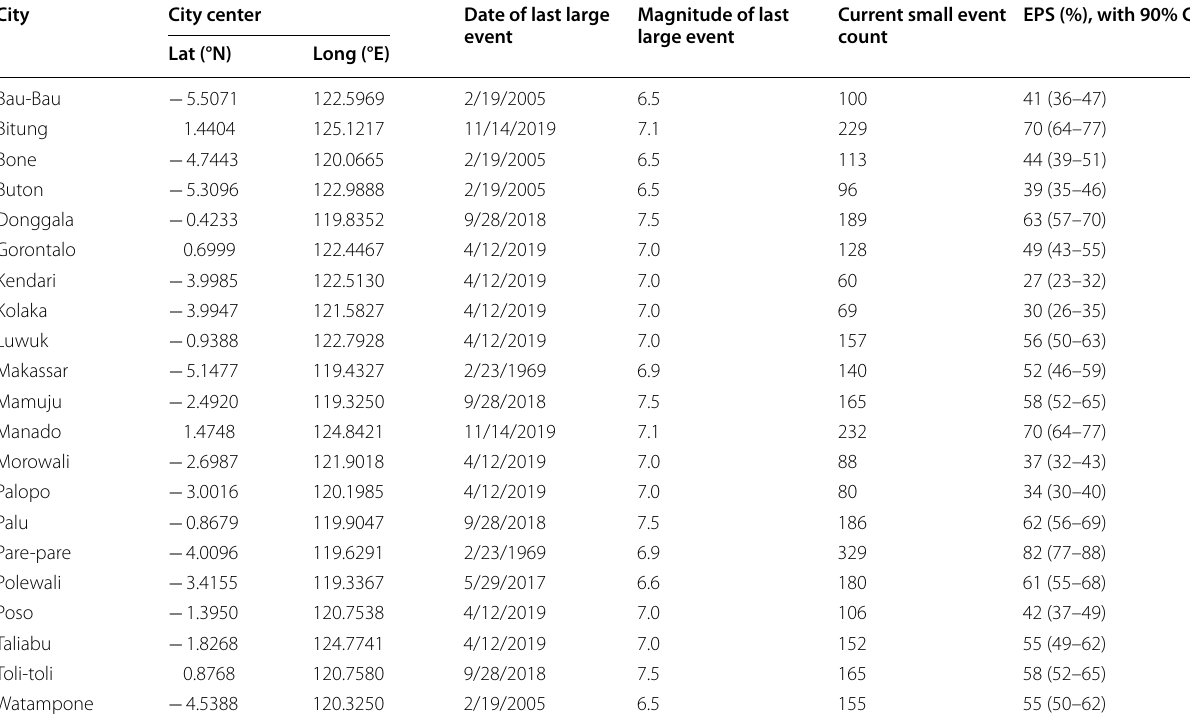
These EPS scores represent the current level of seismic progression of each city region in its cycle of large earthquakes. However, as mentioned before, due to the stationary Poisson process in Sulawesi, these EPS scores do not have any relevance to the associated seismic risk in the study